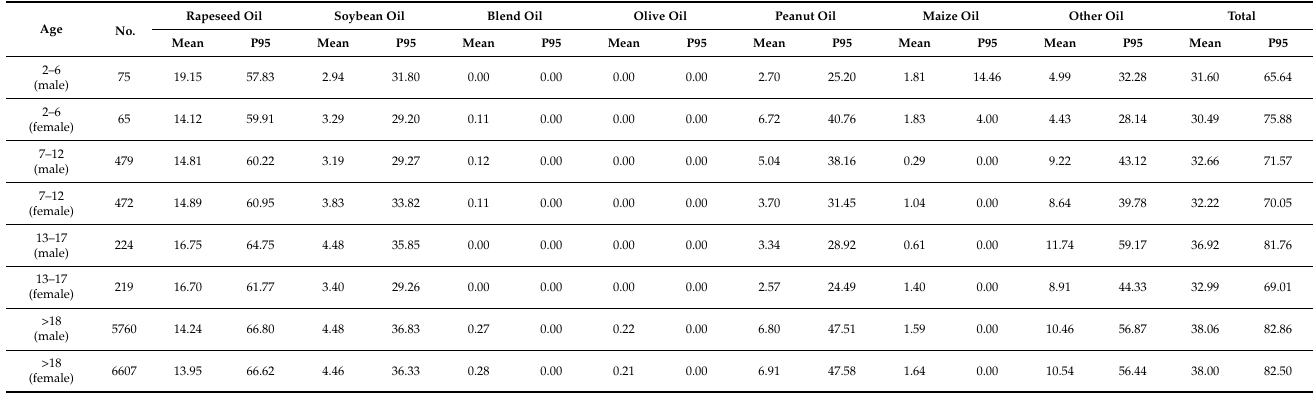
Table 2. Estimated lognormal probability density functions describing the ranges of possible oil consumption rates (g/day) for groups in the study.